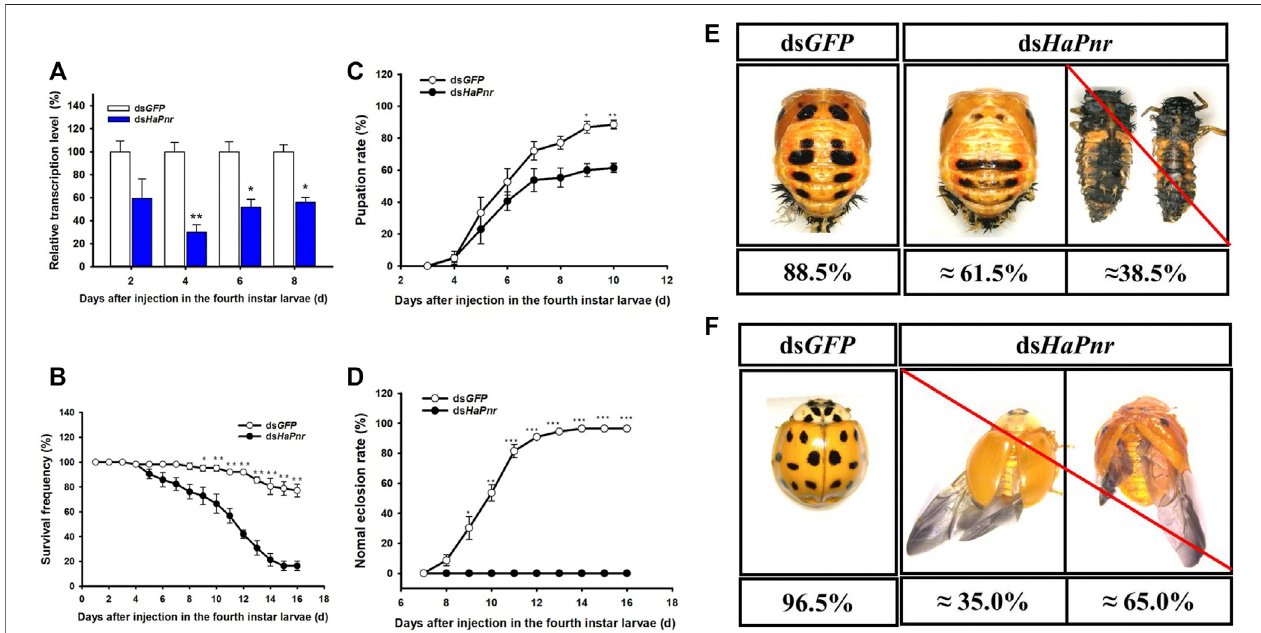
FIGURE 4 | Suppression of HaPnr transcript in the fourth instar larvae of H. axyridis injected with dsHaPnr and dsGFP at 300 ng/larva asdetermined by RT-qPCR (A) .Thetime-dependentlarvalsurvivalfrequency (B) ,pupationrate (C) ,and normaleclosionrate (D) in dsHaPnr and dsGFP -treatedlarvae.Thephenotypeofpupae (E) and adults (F) that injected with dsGFP and dsHaPnr with 300 ng/larva in the fourth instar larvae. The results are presented as the mean and standard errors of three replicates;eachwasperformedwithanRNAsamplepreparedfromthreeinsects.Asterisksabovethestandarderrorbarsindicatesigni fi cantlydifferences(Duncan tests, p <